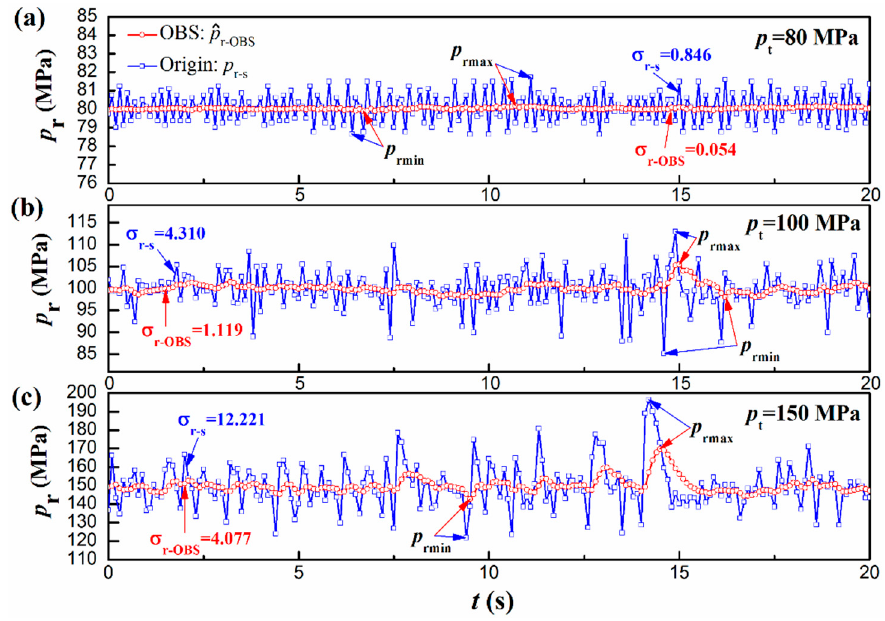
Figure 6. Measured rail pressure of 200 injection cycles for ˆ p r − OBS , p r − s and p r − s under three different target pressures of ( a ) p t = 80 MPa, ( b ) p t = 100 MPa, and ( c ) p t = 150 MPa. The cycles of maximum and minimum pressure are indicated in the graphs.